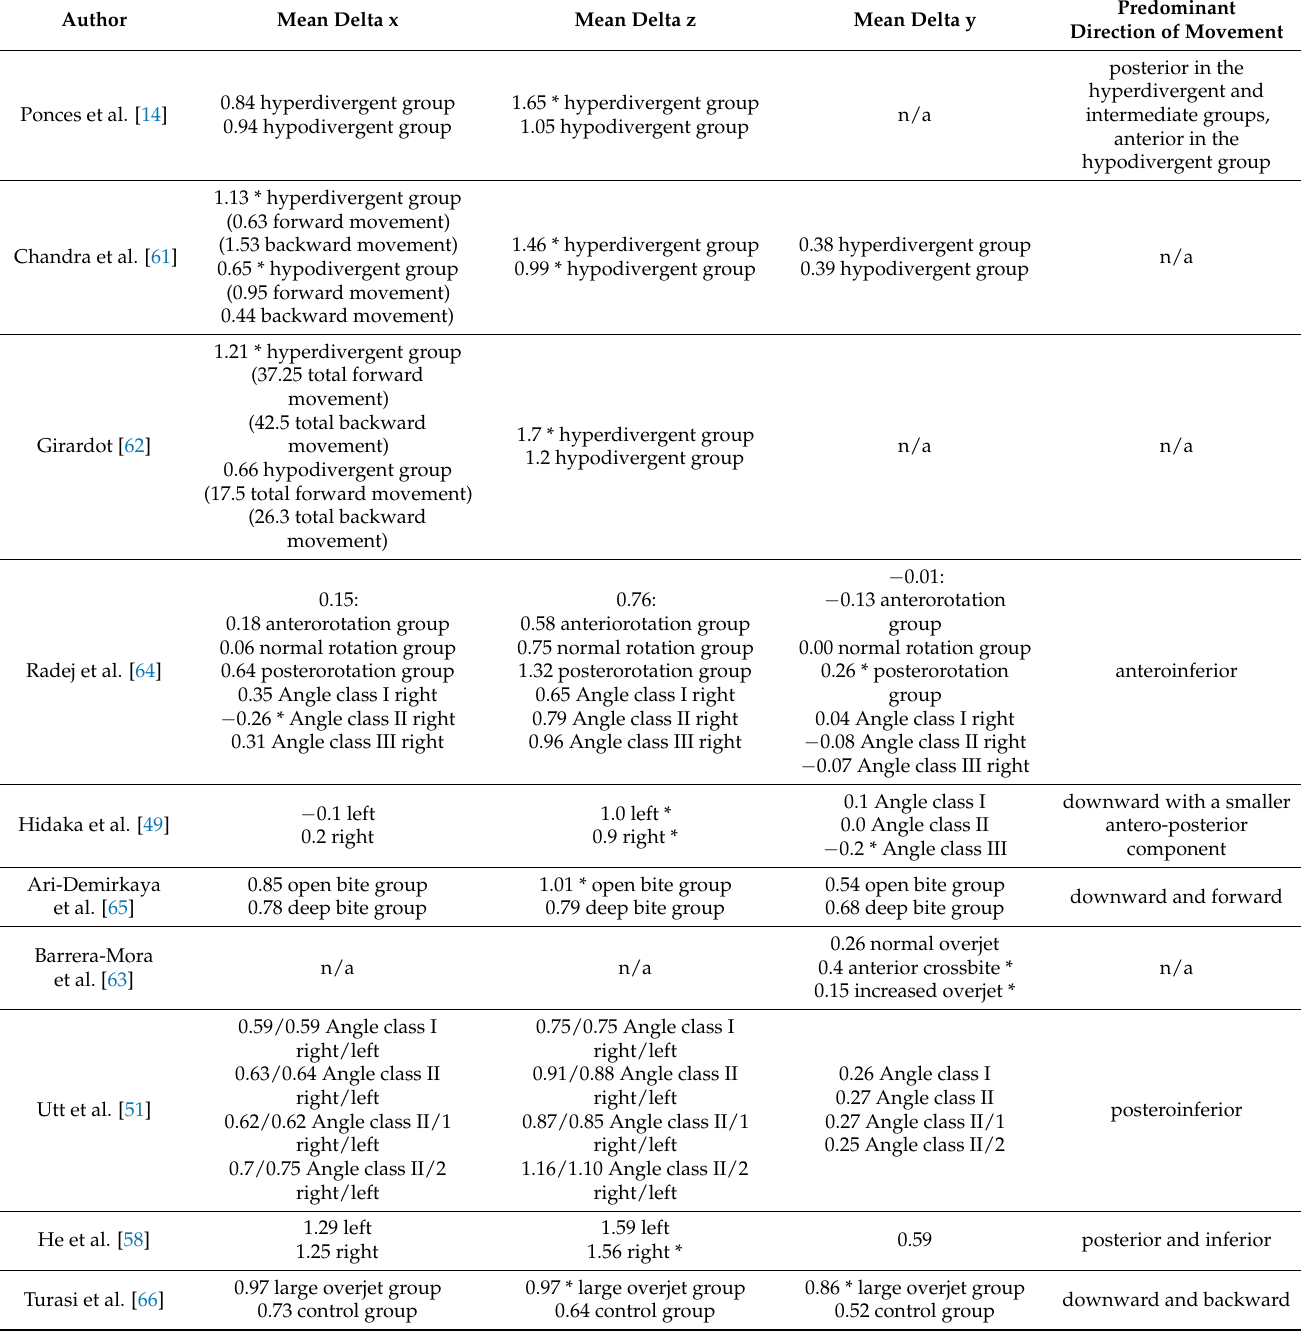
Table 4. Mean values of delta x, delta y, and delta z with division of patients into groups. (in